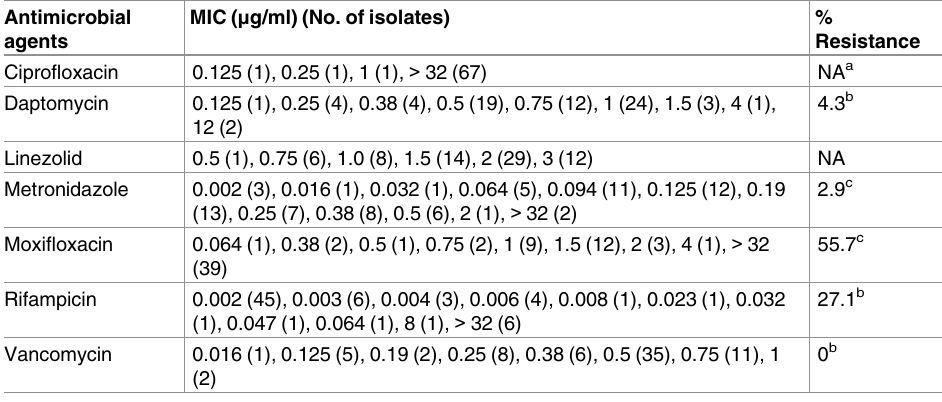
Table 1. Antimicrobial susceptibility of 70 C . difficile isolates from two Korean hospitals. Antimicrobial